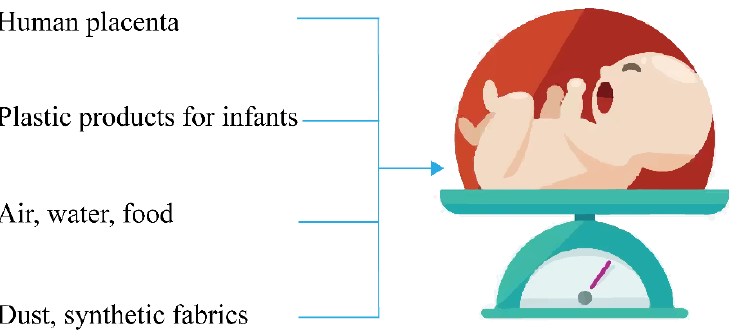
Figure 5. Pathways of microplastic threatening the health of infants and young children.